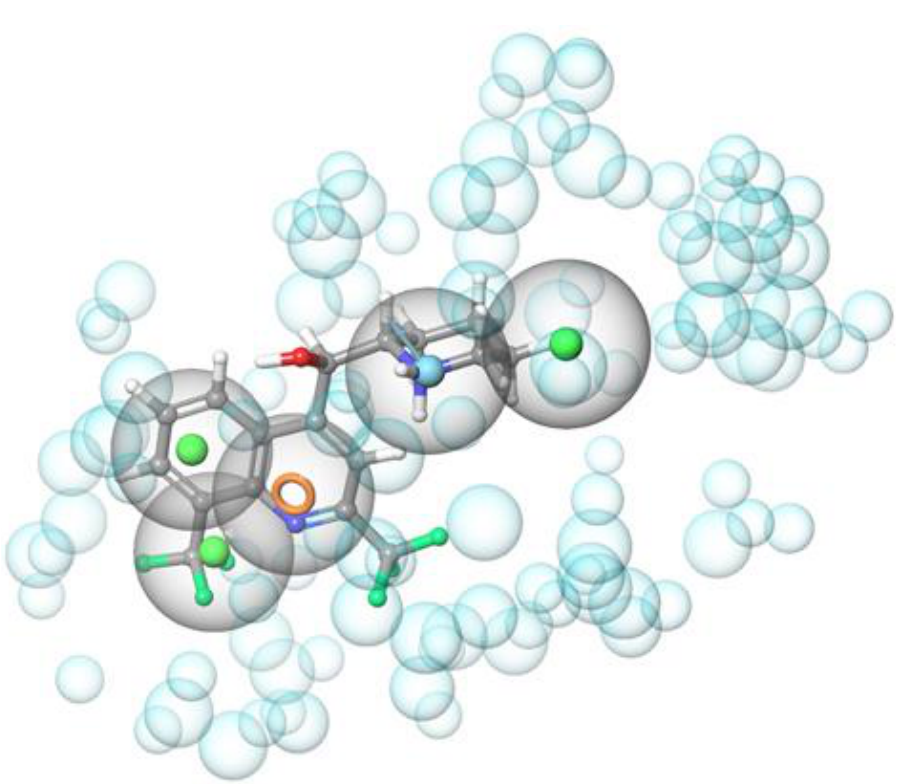
Figure 3. Graphical representation of mefloquine superimposed to the pharmacophoric model. The hydrophobic features (green spheres) are matched by the trifluoromethylphenyl moiety (the most important molecular portions of the mefloquine structure are highlighted in Figure S1) and the alkyl portion of the piperidine ring, the aromatic ring feature (orange circle) is mapped by the pyridine core, and the hydrogen bond donor group (cyan sphere) is represented by the basic piperidine nitrogen atom. Excluded volumes (light cyan spheres of variable size) are also displayed.